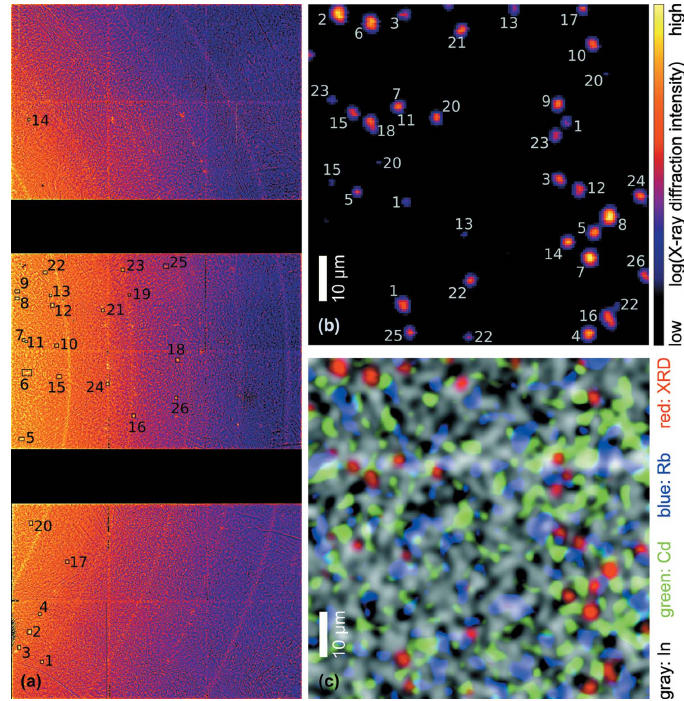
Figure 5 ( a ) An XRD detector image summed over the mapped area of a solar cell with a polycrystalline ACIGS absorber layer. The rectangles with adjacent numbers denote diffraction peaks from individual ACIGS crystallites. ( b ) A real-space map of the XRD intensity with the crystallites attributed to their position in the reciprocal-space image shown in ( a ). For example, locations in ( b ) indicated by ‘1’ provide the Bragg peak in ( a ) indicated by the same number. ( c ) A combined map of the XRD intensity (red) with the elemental distributions of In (gray), Cd (green) and Rb